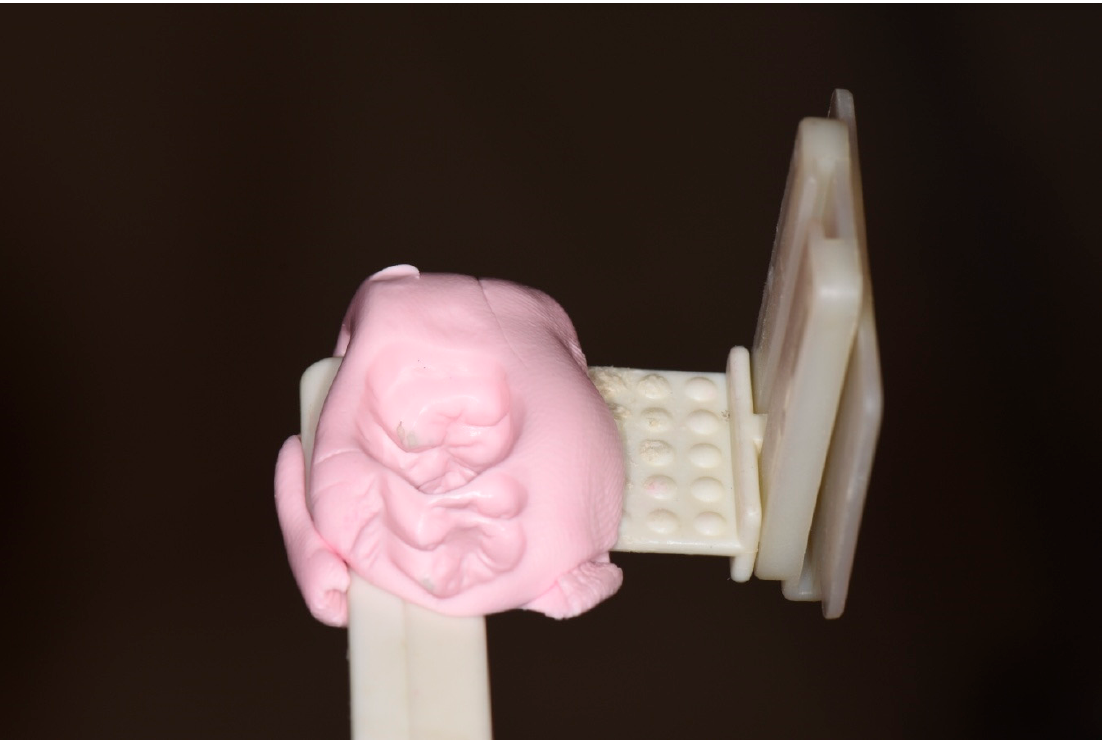
Figure 2. Custom bite blocks for periapical radiographs.